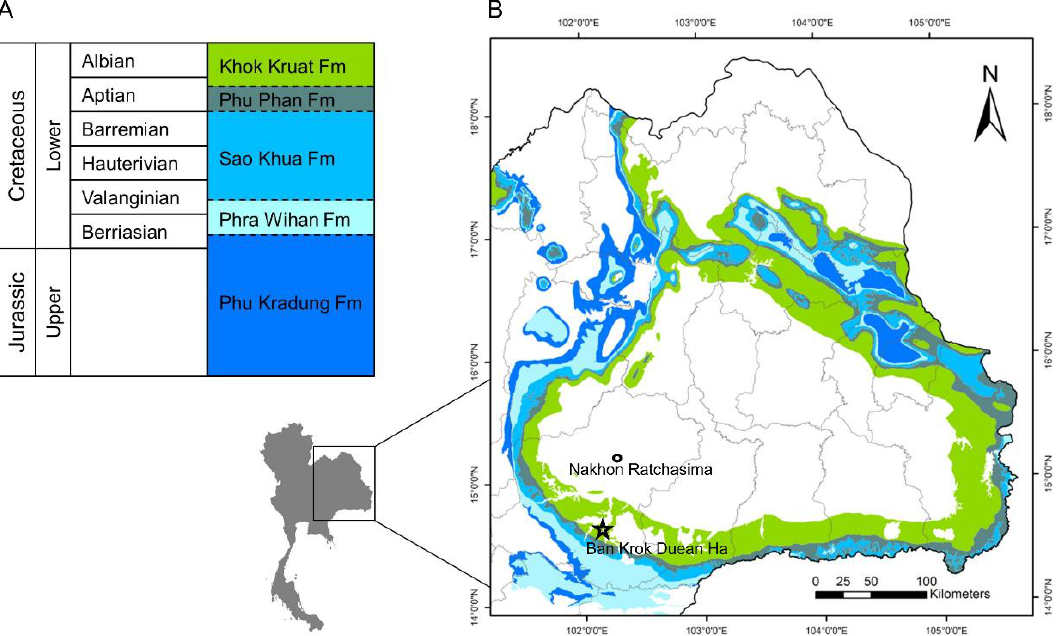
Figure 1. ( A ) Stratigraphy of the Khorat Group. ( B ) Map showing the formations of the Khorat Group, Khorat Plateau, northeastern Thailand, with the location of Ban Krok Duean Ha indicated (star). (Modified from Manitkoon et al. [22]).